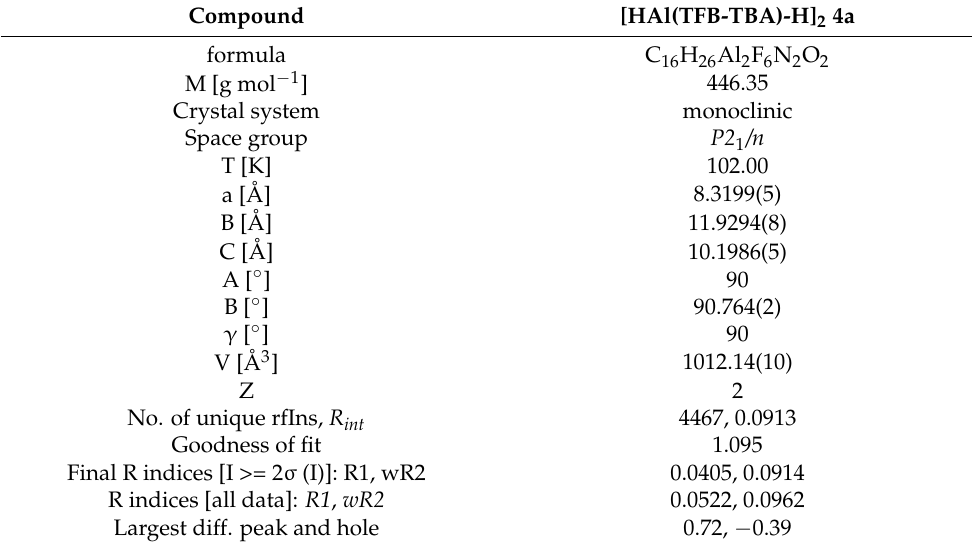
Table 1. Selected Crystallographic Data and Collection Parameters for Compound [HAl(TFB-TBA)- H] 2 4a .